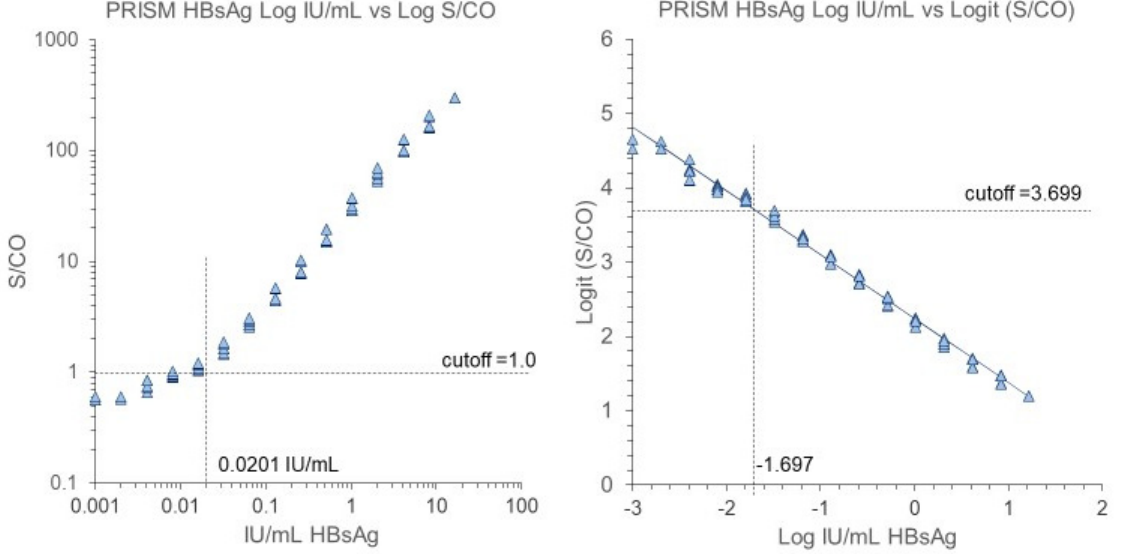
Figure 1. Calibration curves of twofold WHO 00/588 HBsAg standard dilutions tested twice in duplicate in HBsAg PRISM assay showing better linearization of the regression line until cutoff level when plotting Log IU/mL against Logit S/CO ratio ( right graph) than Log IU/mL against Log S/CO ( left graph).